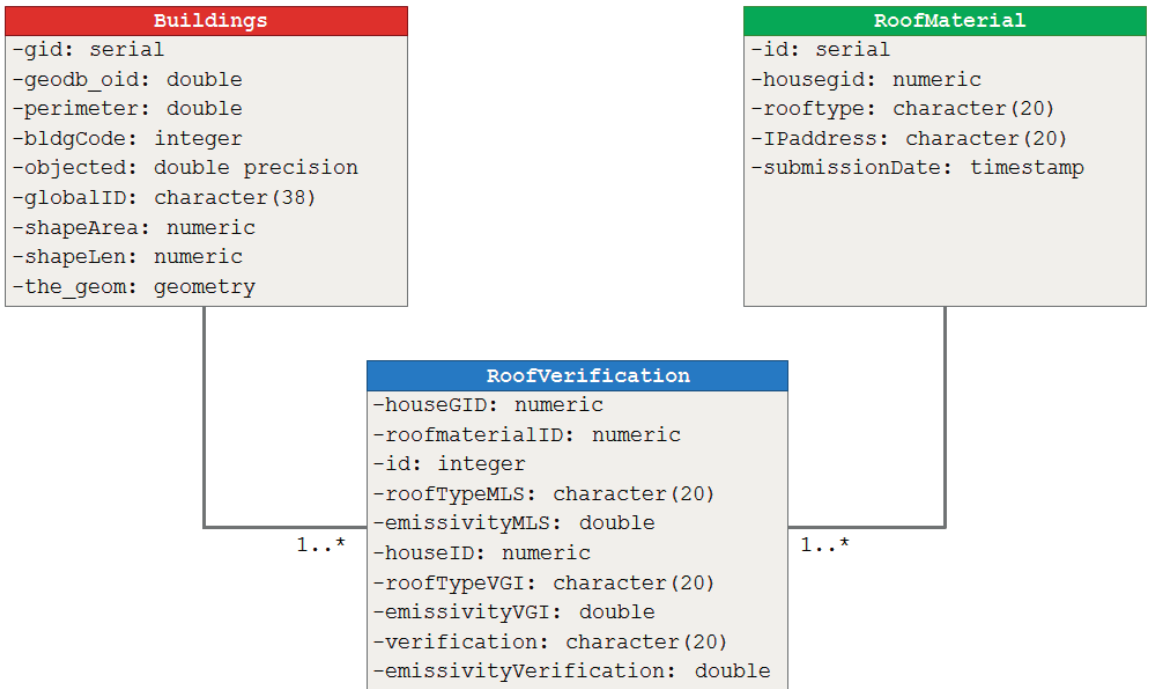
Figure 4. Data Model Design (DMD) diagram for the database tier as seen in